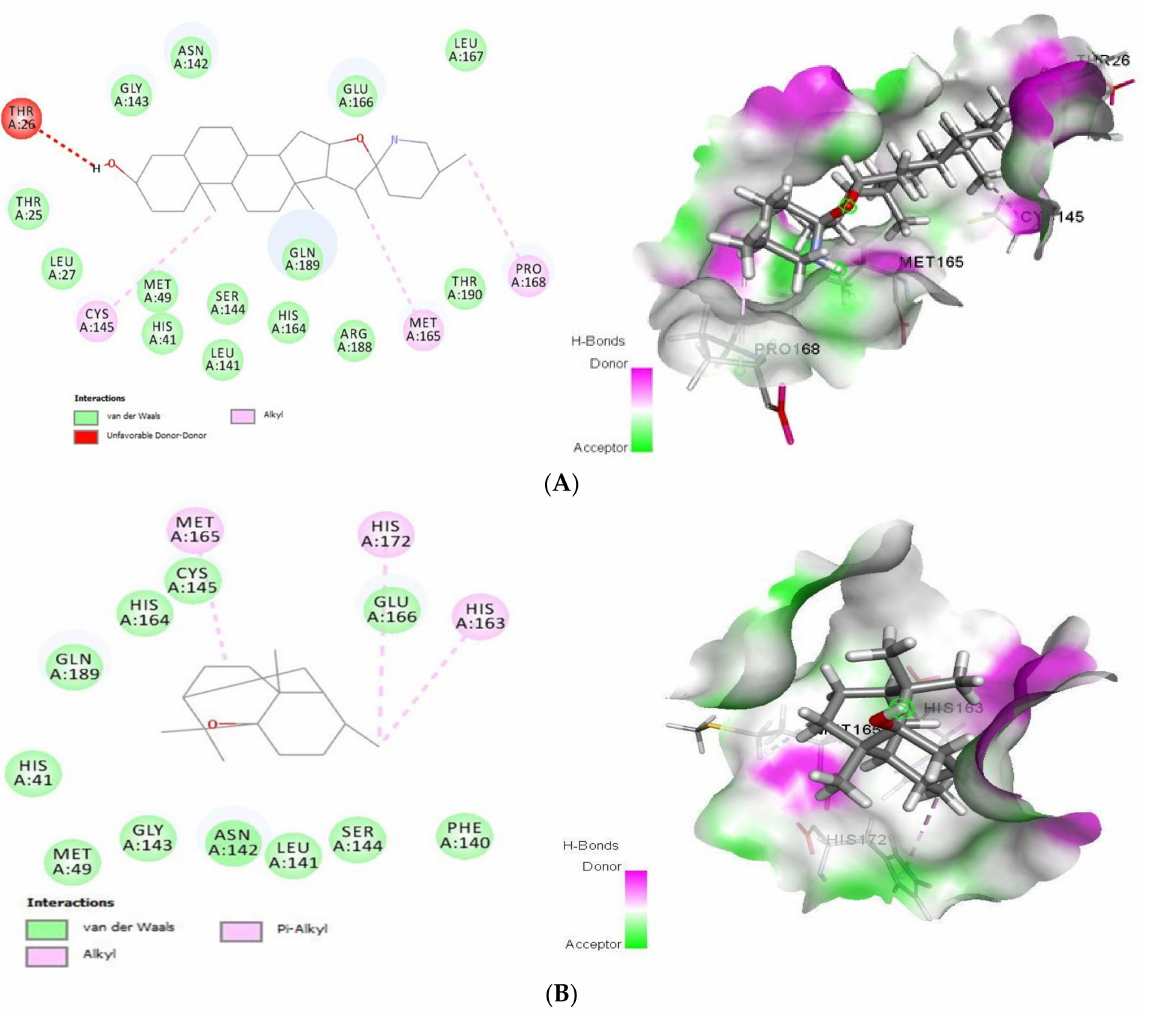
Figure 1. 2D (left) and 3D (right) of tomatidine ( A ) and patchouli alcohol ( B ) with the active site of 6LU7. ( A ): Tomatidine- 3CL-protease (PDB ID: 6LU7; (Gold Fitness Score 41.42). Type of the binding: van der Waals: Thr25, Leu27, Met49, His41, Ser144, Leu141, His164, Gln189, Arg188, Thr190, Glu166, Gly143, Asn142, Leu167; Unfavorable donor-donor: Thr26; Alkyl: Cys145, Met165, Pro168. ( B ): Patchouli alcohol-3CL-protease (PDB ID: 6LU7); (Gold Fitness Score 30.65). Type of the binding: van der Waals: His41, Met49, Gly143, Asn142, Leu141, Ser144, Phe140, Cys145, His164, Glu166, Gln189; Alkyl: Met165, His172,